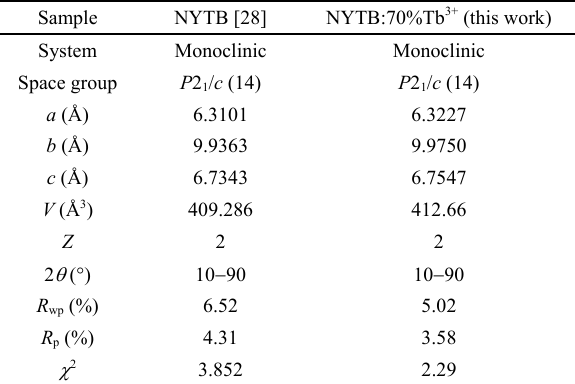
Table 1 Rietveld refinement data for NYTB:70%Tb 3+